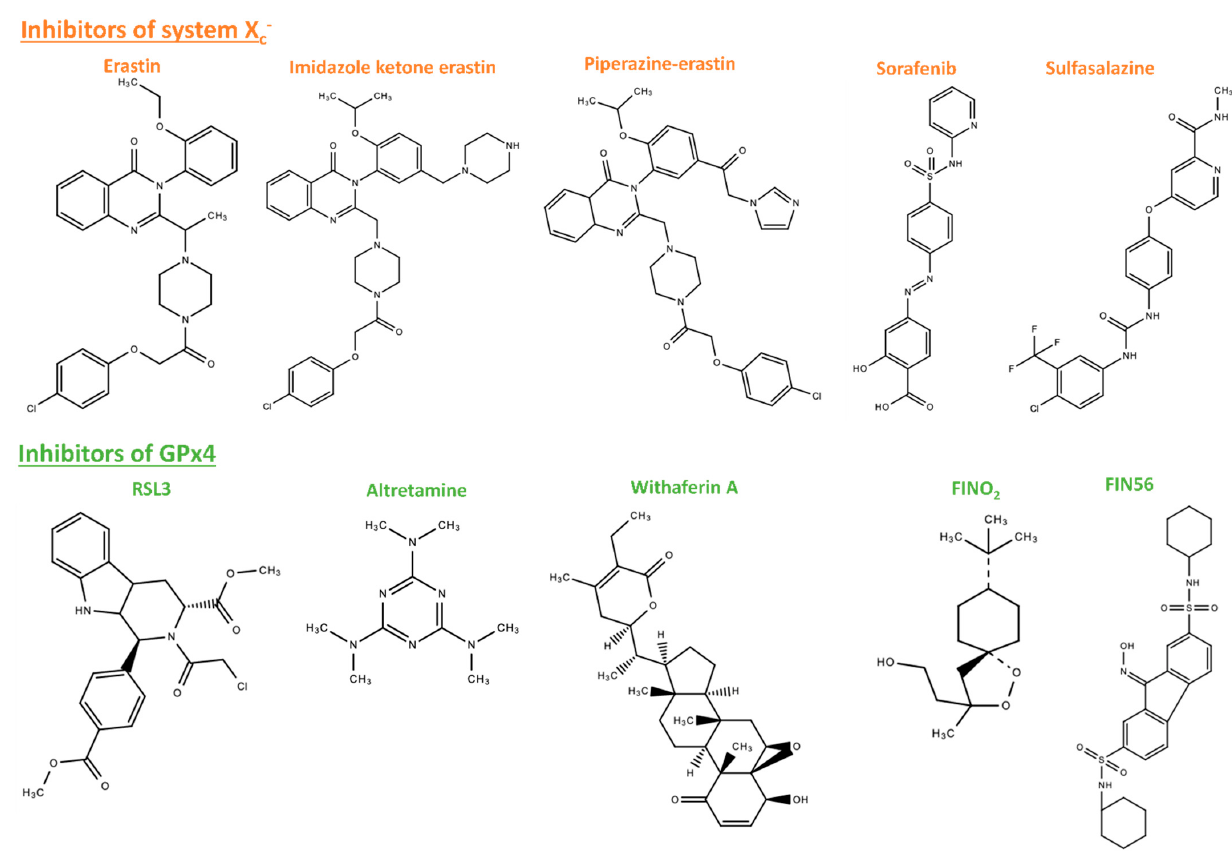
Figure 4. Chemical structures of ferroptosis inducers